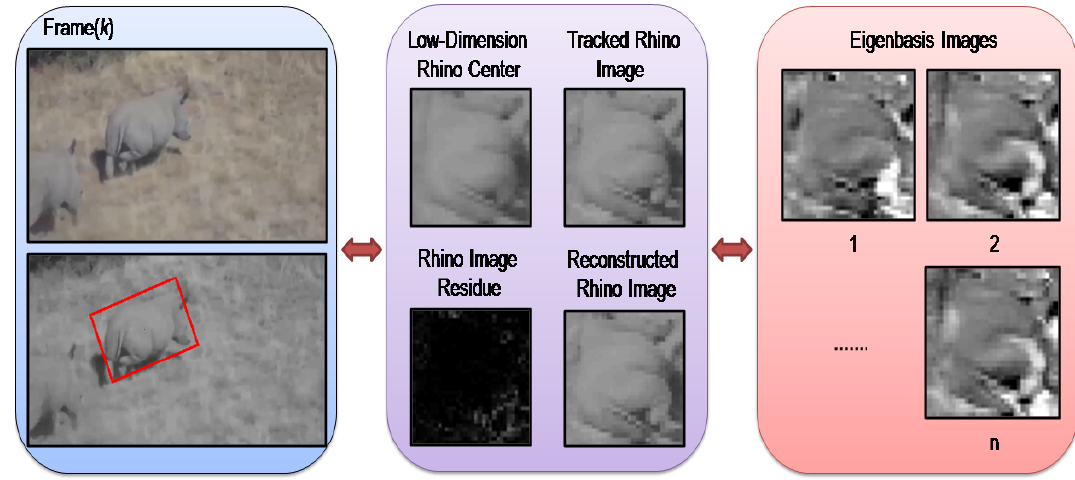
Figure 1. The PCA subspace-based tracking of a 3D rhino in our work, where each rhino image is re-sized to 32 × 32 pixels, and the reconstructed rhino image is constructed using the eigenbasis. Moreover, the eigenbasis images are sorted based on their according